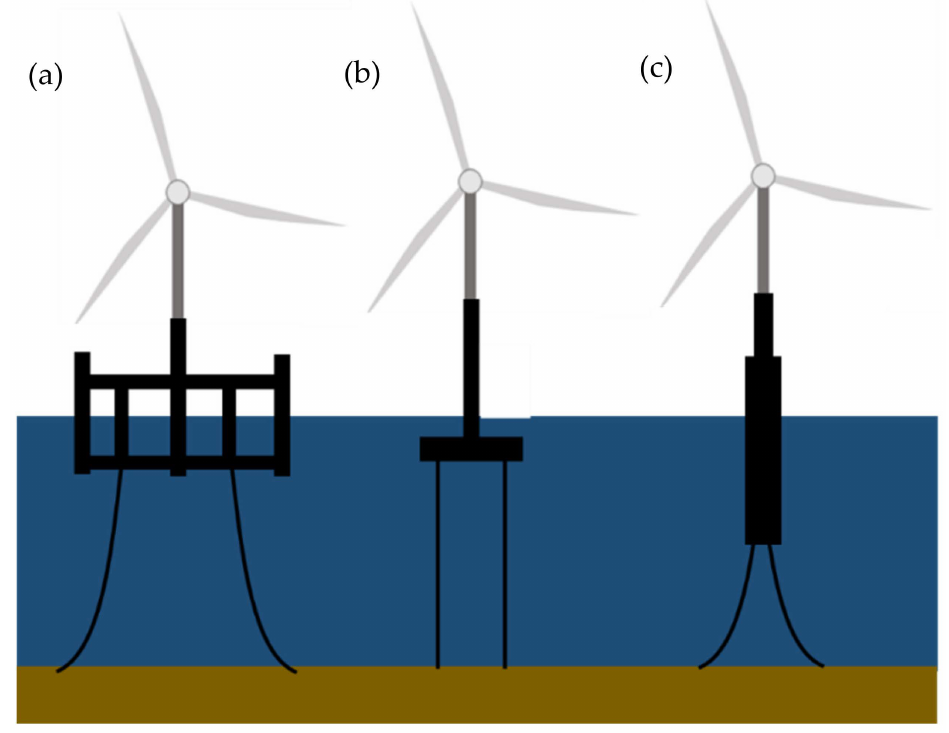
Figure 1. ( a ) Semi-submersible, ( b ) TLP ( c )